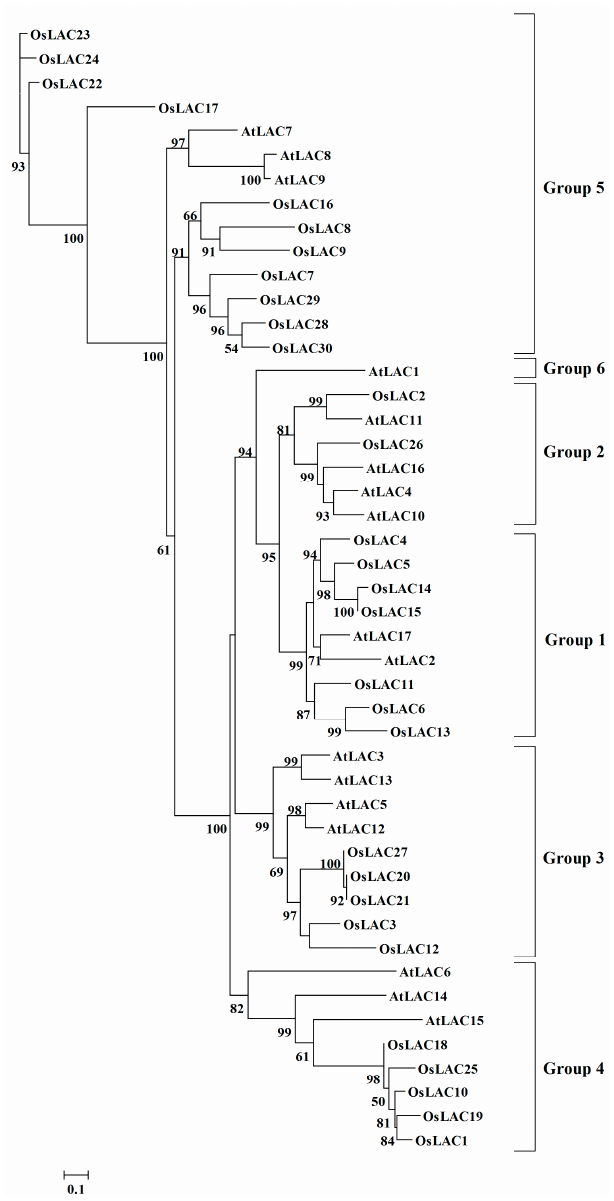
Figure 2. Phylogenetic tree of the rice and Arabidopsis laccases obtained by protein sequence alignment of rice and Arabidopsis laccases.